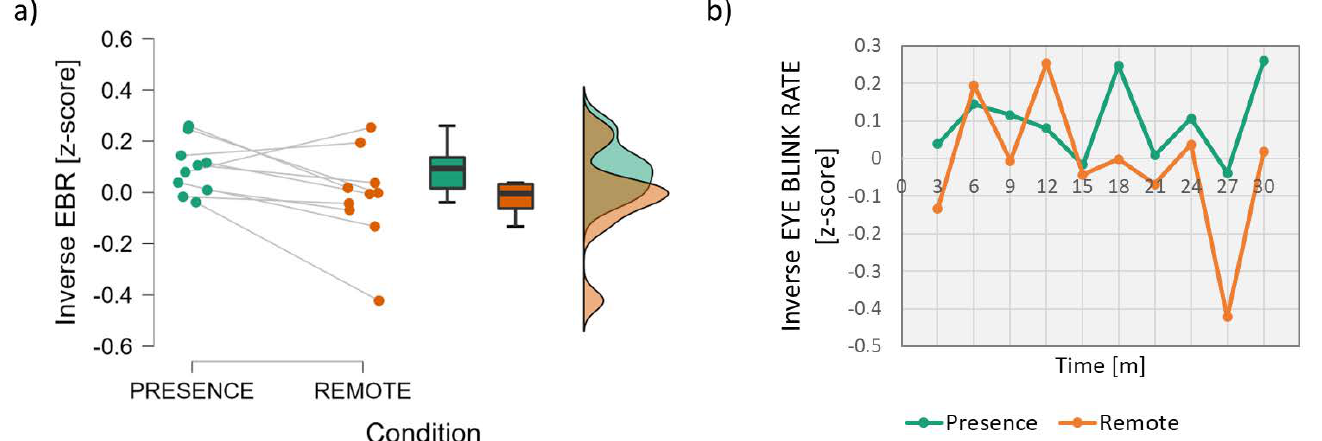
Figure 3. Analysis of the inverse Eye Blink Rate parameter. On the left ( a ), mean and confidence interval (95%) of the distributions related to the two conditions (In-presence and Remote). On the right ( b ), the dynamics of the inverse EBR averaged across students during the time span of the lesson.